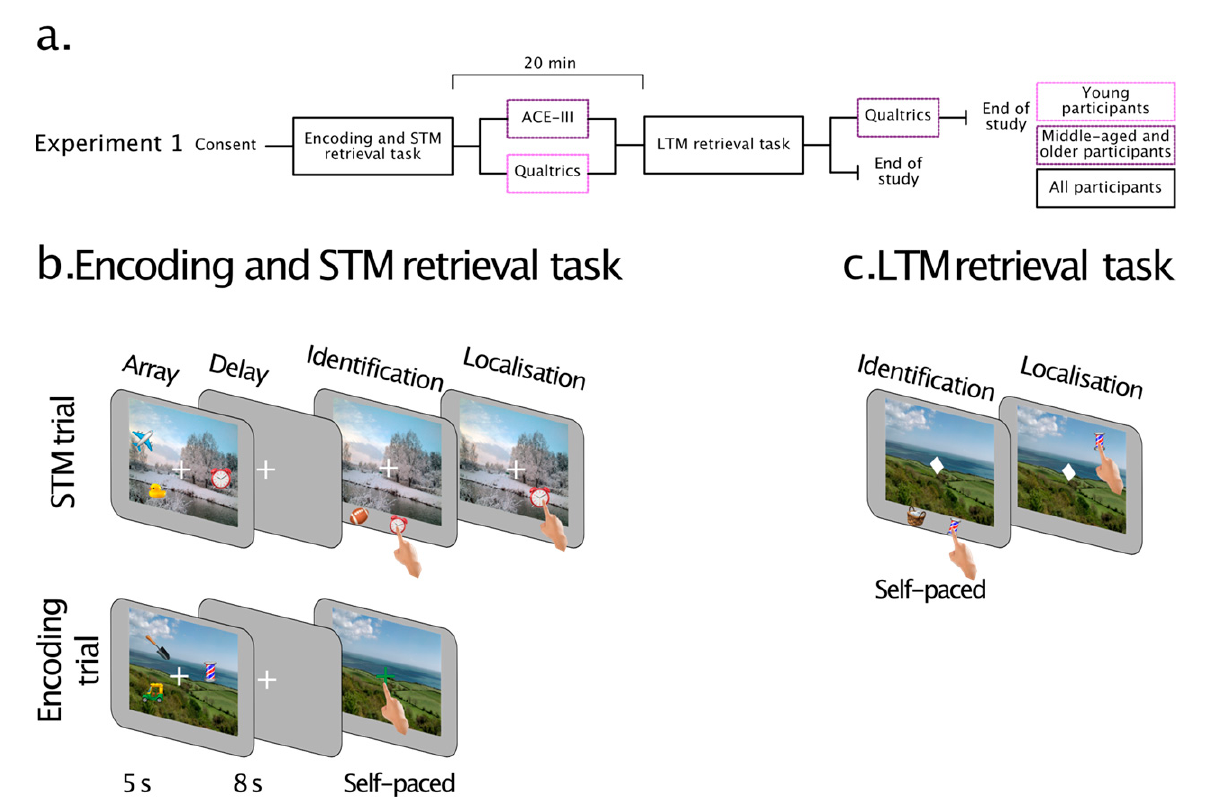
Figure 1. ( a ) Timeline for Experiment 1. ( b ) STM/Encoding task in Experiment 1. Each trial started with a memory array of 1 or 3 objects embedded within a scene, followed by a delay. In the short-